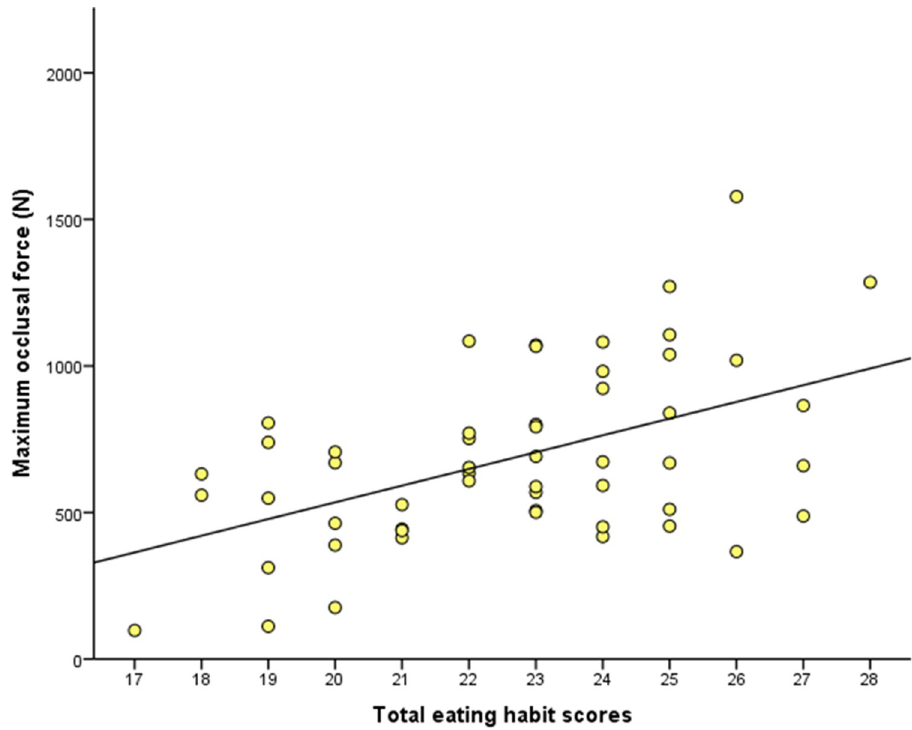
Fig 2. Scatterplot showing the relationship between maximum occlusal force and total eating habit scores. The regression line was calculated by simple regression analysis (maximum occlusal force = 57.075 � ×− 606.692; P < 0.001).